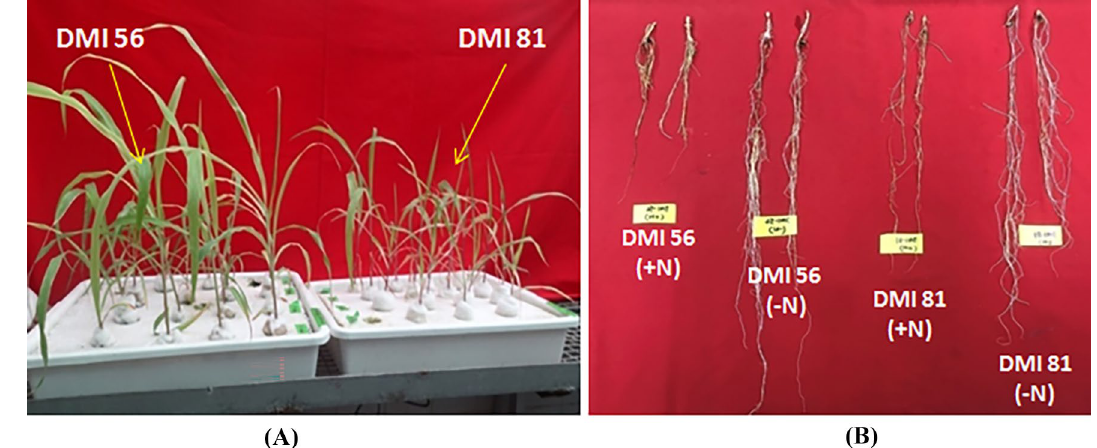
Figure 1. Effect of N-stress on two contrasting maize inbred lines; DMI 56 (tolerance to nitrogen stress) and DMI 81 (susceptible to nitrogen stress) in ( A ) shoot and ( B ) root growth in hydroponic medium. Plants were grown hydroponically under N− deficient (− N) and sufficient/control (+ N) conditions.